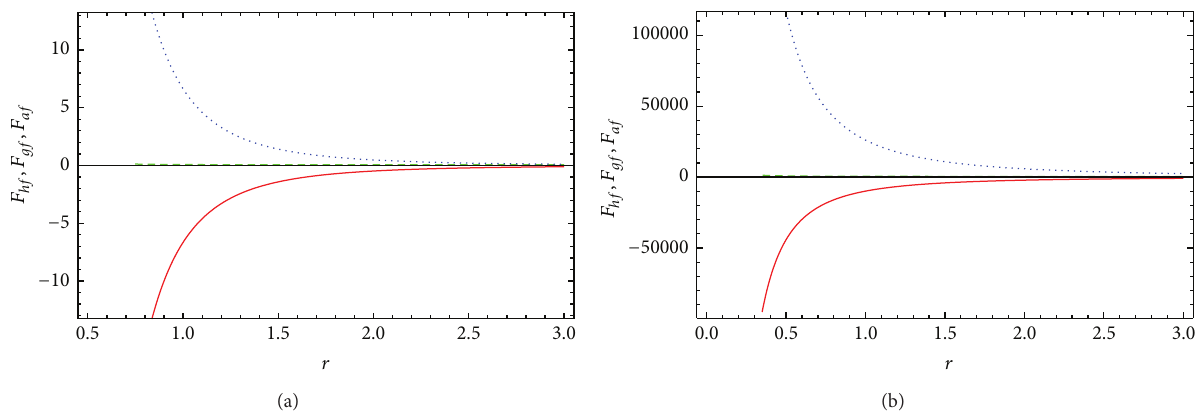
Figure 7: Plots of equilibrium conditions for exponential (a) and logarithmic (b) 𝑓(𝑇) models. Red solid curve represents 𝐹 ℎ𝑓 , green dashed curve represents 𝐹 𝑔𝑓 , and blue dotted curve represents 𝐹 𝑎𝑓 versus 𝑟